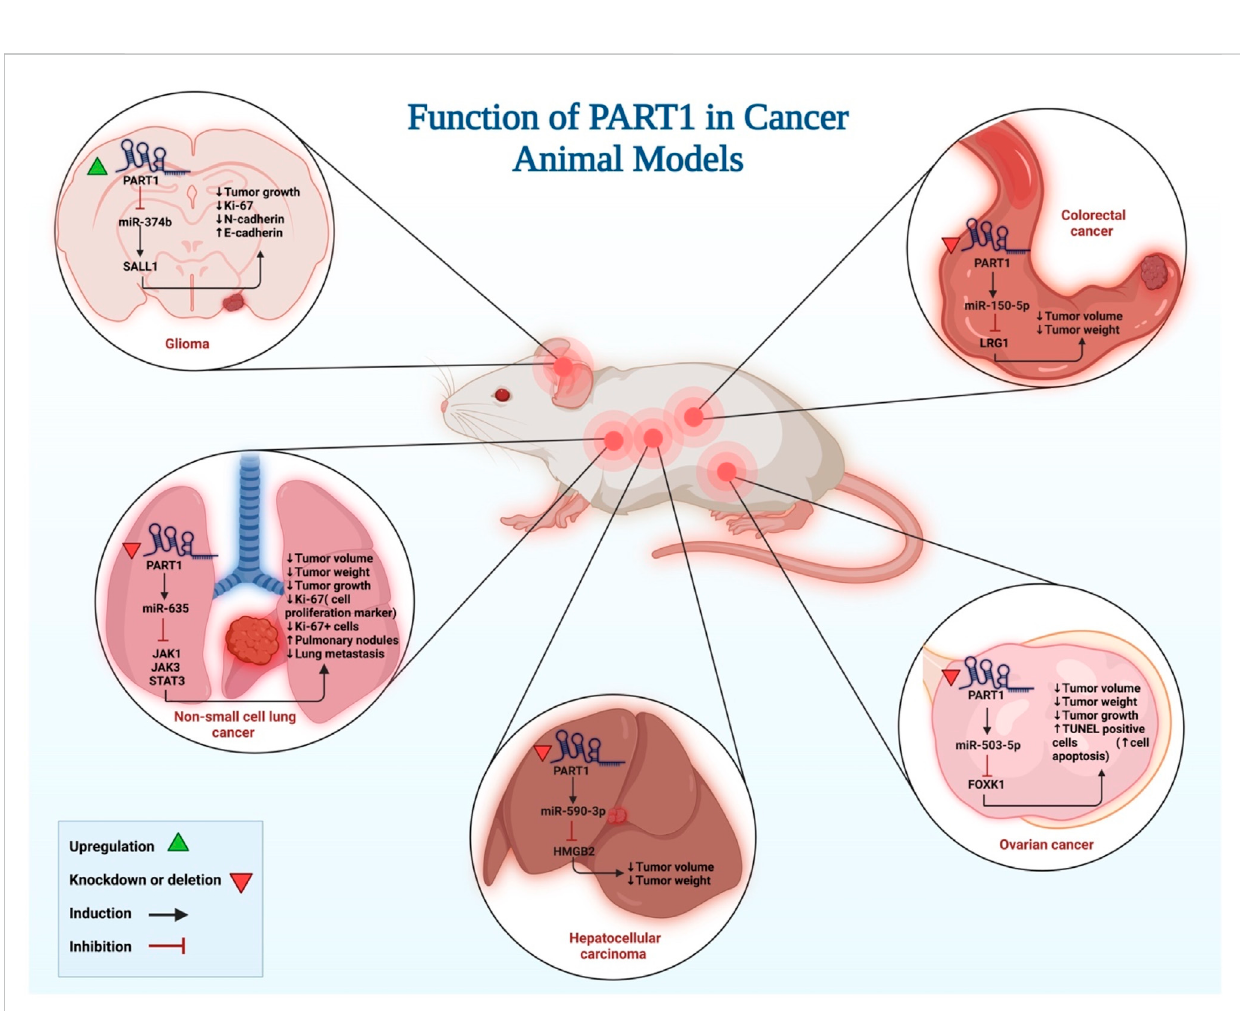
FIGURE 3 Anillustration depictstherolesofPART1 activation andsilencingintumorformation inxenograftmodels, aswellasthesignalingpathwaysinvolved.